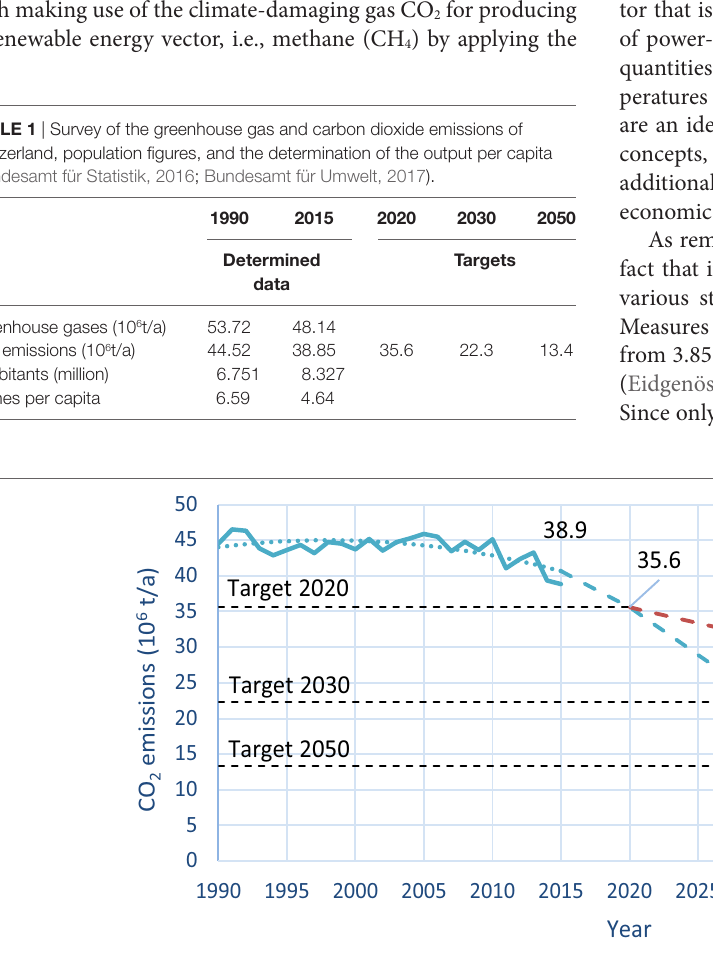
FigUre 1 | Trend in CO 2 emissions resulting from the values laid down in the CO 2 Act and also the Paris Climate Agreement. The blue line describes the real carbon dioxide emissions. Given the fluctuating figure, in particular between 2009 and 2015, the pattern of CO 2 emissions has been smoothed between 1990 and 2015 (blue dotted line). The dashed lines describe the targets of the Paris Agreement (red: emissions within Switzerland and blue: include additional foreign measures) (Eidgenössisches Departement für Umwelt, 2016).